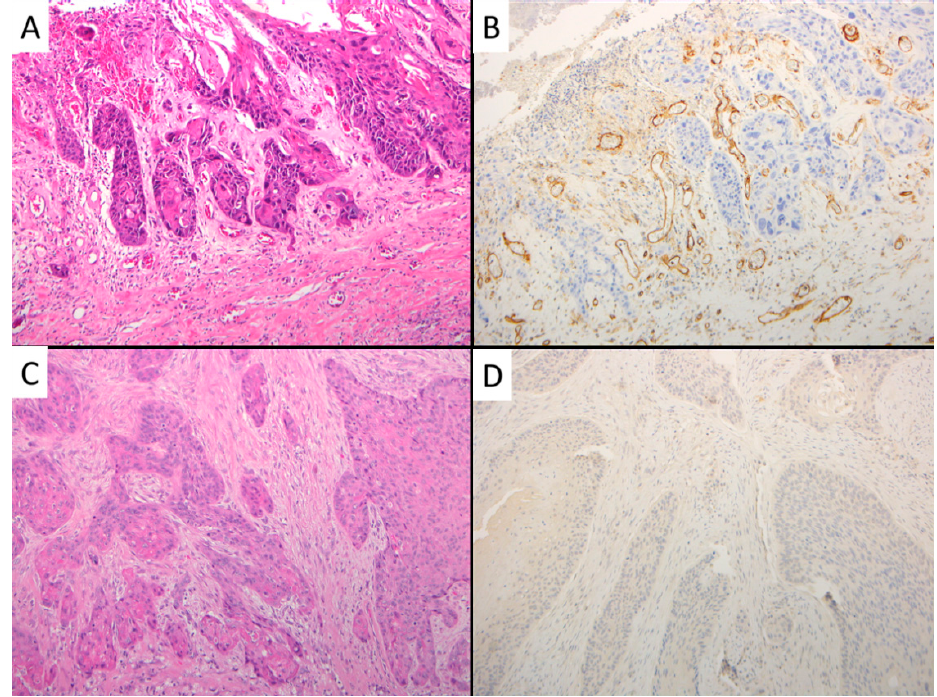
Figure 2. Representative cases with matched microvessel stain with CD105. ( A ) Squamous cell carcinoma with moderate differentiation and high MVD as shown by CD105 stain ( B ). ( C ) Squamous cell carcinoma with moderate differentiation and low MVD as shown by CD105 stain ( D ). A, C: Hematoxylin and eosin stain. A, B, C, D: Original magnification: 100×.